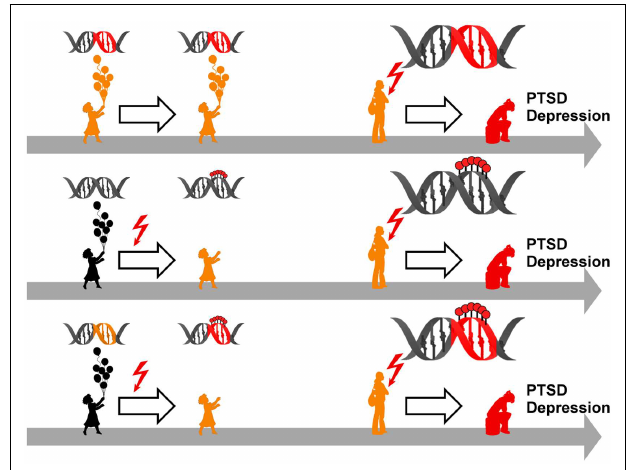
FIGURE 5 | Model for epigenetic risk factors in PTSD and depression . Genetic mutations (red segment of the DNA double helix) can confer an increased vulnerability to PTSD and depression which manifest following anew exposure to stressful life events (red flash). Although carrying a predisposition to disease (symbolized by orange colored child and adolescent), such individuals can stay healthy in the absence of trauma and stress (upper panel). Early life adversity (red flash) can elicit epigenetic programing of stress genes via DNA (de-)methylation (symbolized by red lollipops on DNA double helix) leading to altered expression.These alterations confer an increased vulnerability to later on trauma and stress and ultimately result in manifestation of PTSD and depression (middle panel). Genetic mutations (orange segment of the DNA double helix) can serve as a substrate for epigenetic programing in response to early trauma and stress (red flash) via DNA (de-)methylation (symbolized by red lollipops on red segment of DNA double helix).This pre-activation can result in PTSD and depression following anew exposure to trauma and stress (lower